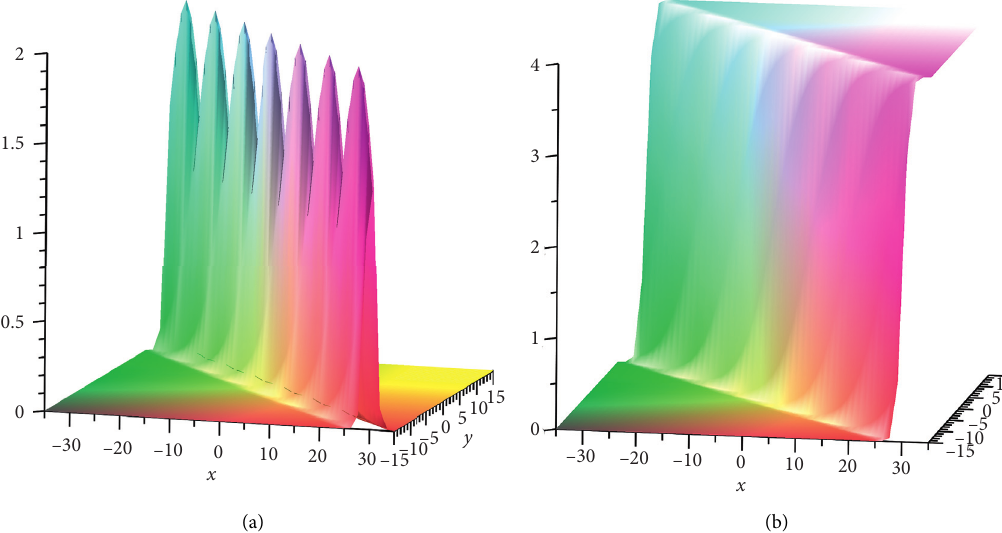
Figure 1: One-soliton solution( u ) v of equation(1)withtheparameterselections a